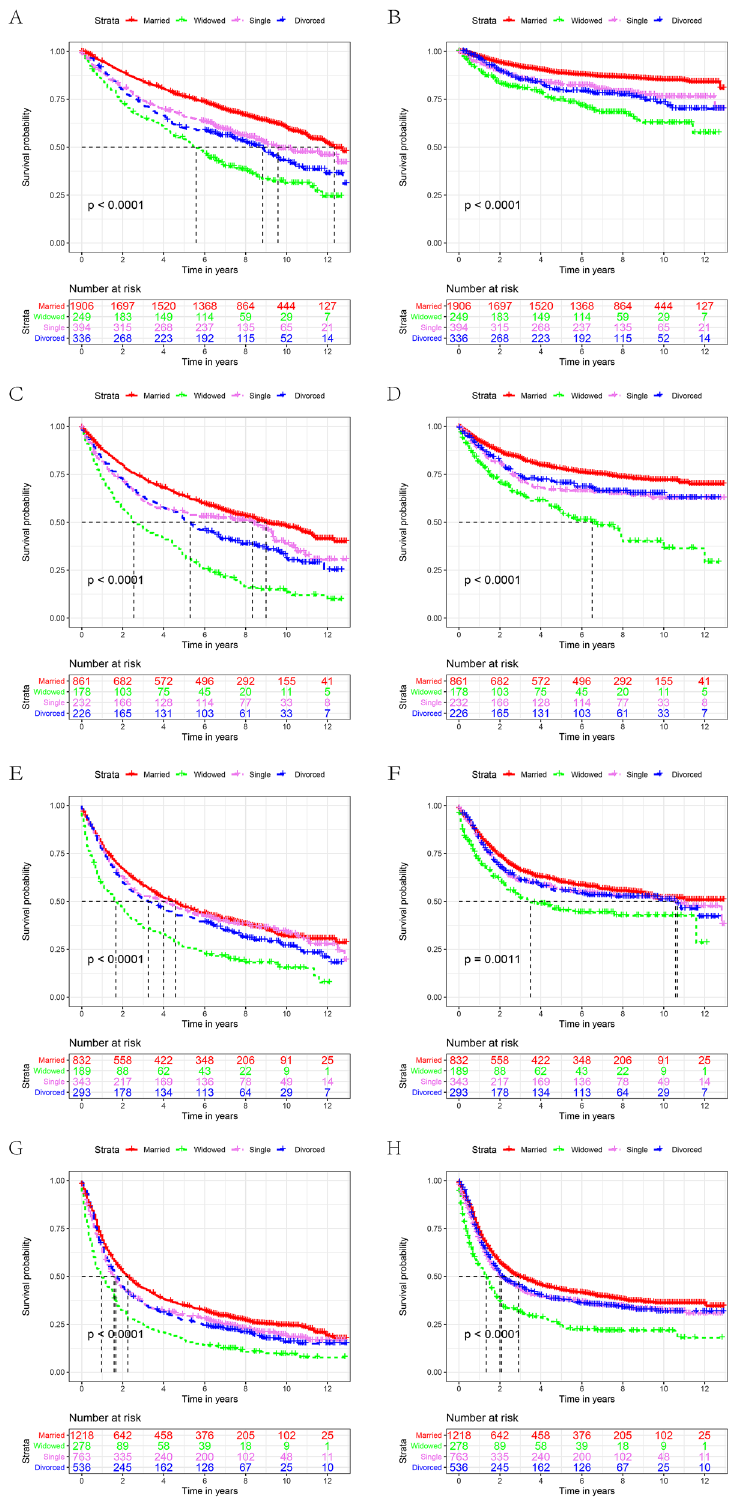
Figure 3. The OS and CSS curves of laryngeal cancer patients with different AJCC stages. A and B, OS and CSS for StageI. C and D, OS and CSS for StageII. E and F, OS and CSS for StageIII. G and H, OS and CSS for StageIV. (OS: overall survival, CSS: cause-specific